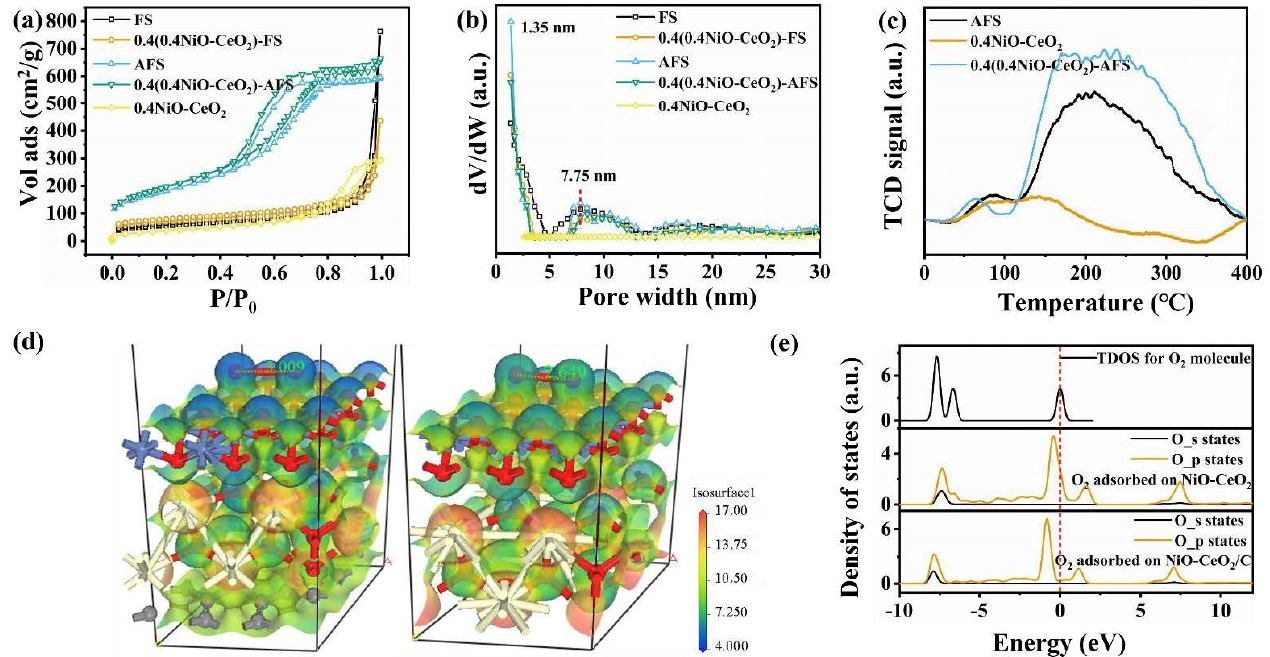
Figure 2. N 2 adsorption–desorption isotherms ( a ), pore size distribution ( b ), and O 2 −TPD patterns ( c ) of different samples. Electrostatic potential map based on optimized adsorption model ( d ). Density of states (DOS) for the O 2 molecule on 0.4NiO−CeO 2 (NiO/CeO 2 model) and 0.4(0.4NiO−CeO 2 )−AFS (NiO/CeO 2 /C model) ( e ). The atoms in yellow, red, blue, and gray are cerium, oxygen, nickel, and carbon atoms, respectively; the left is the NiO−CeO 2 −AFS model, and the right is the NiO−CeO 2 model.